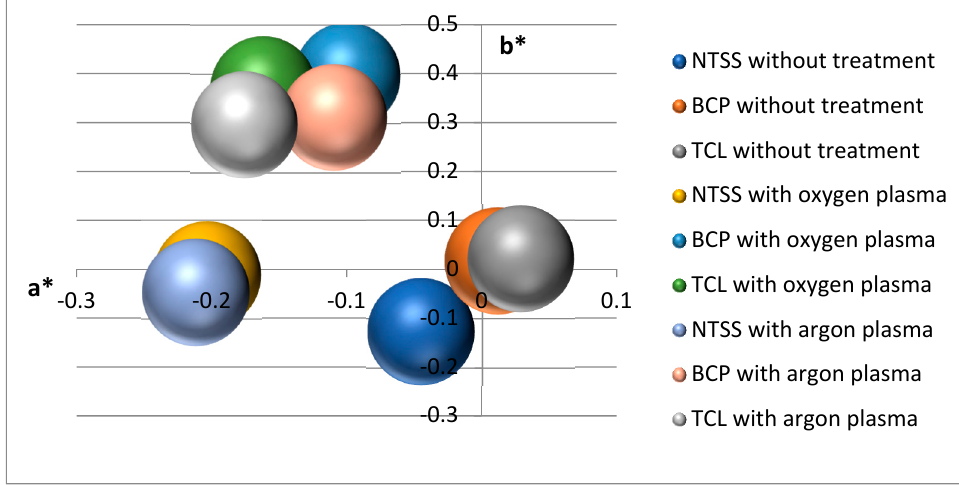
Figure 7. Color changes of the film due to plasma activation (the axes a* and b* describe the green-red and blue-yellow opponent colors, respectively).